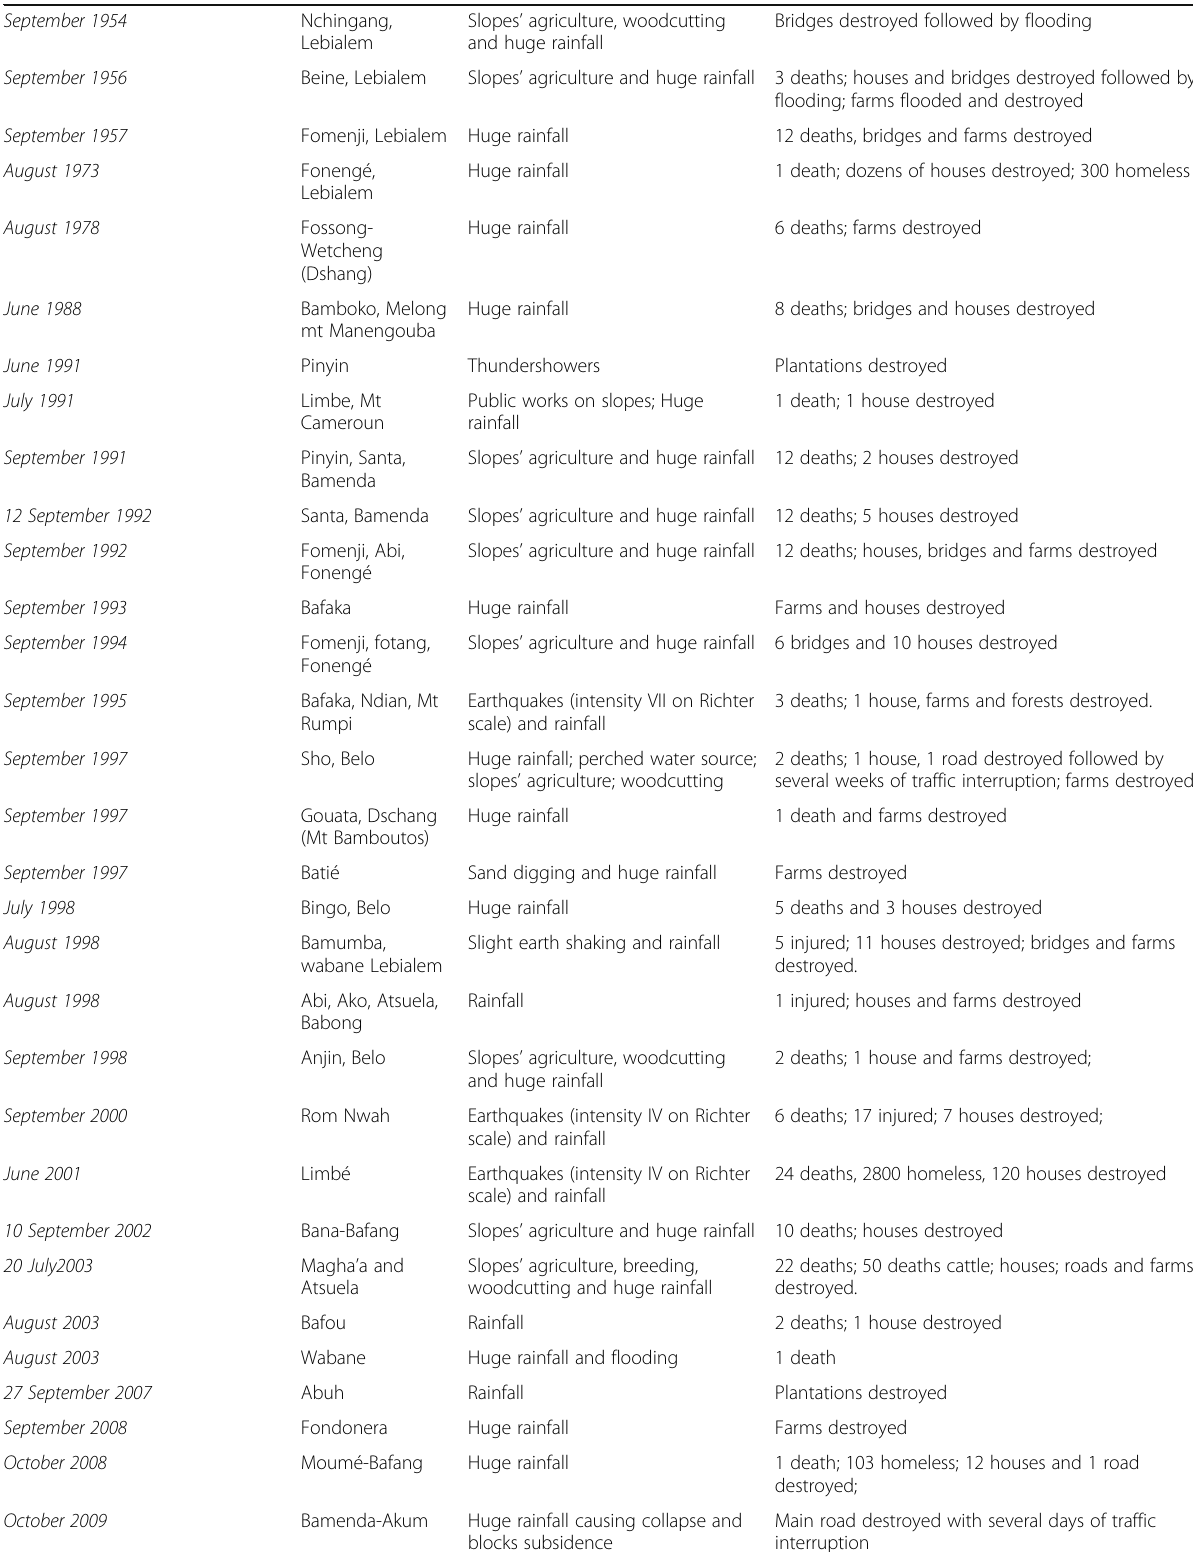
Table 4 Landslide causes and consequences in Cameroon to the best of